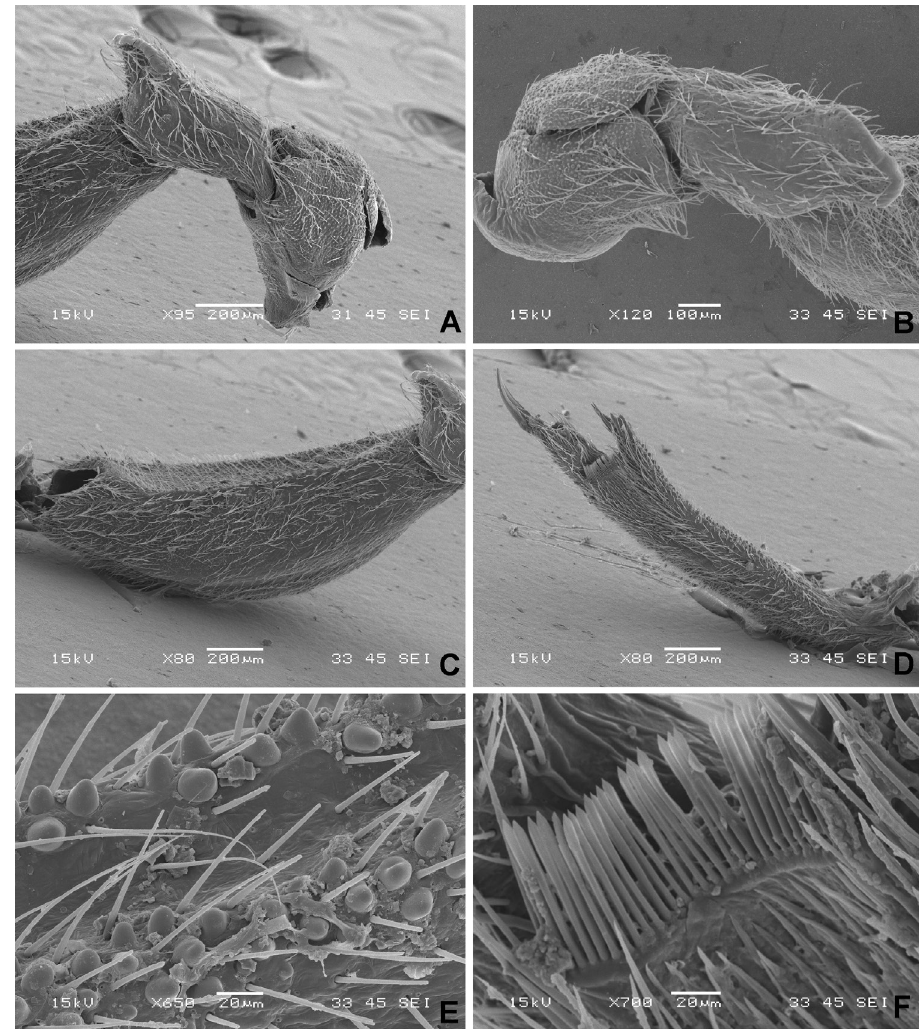
Figure 3. Xenicocephalus tomhenryi sp. n., female holotype, left foreleg, scanning electron micrographs A coxa, trochanter and basis of femur, anterior view B coxa and trochanter, ventral view C femur, anterior view D tibia, anterior view E detail of ventral concavity of tibia F bristle comb of tibial apex, anterior Type material. Holotype female, labelled: 'Ecuador camino / Aloag-Tandapi / Pr. Pichincha 2600m / 12.II.1983 A. Roig [handwritten] // Drake Colln. ex / J. Maldonado C. / Coll. 1996 [printed] // Xenicocephalus / sp. nov. / P. Baňař det. 2014 [handwritten, partly printed] // HOLOTYPE / Xenicocephalus / tomhenryi sp. nov. / P. Štys & P. Baňař det. 2018 [printed red label]’. Dry-mounted, left fore- leg and right wings mounted separately; right middletarsus missing. Deposited in Department of Entomology of National Museum of Natural History, Washington, D.C. (USNM).